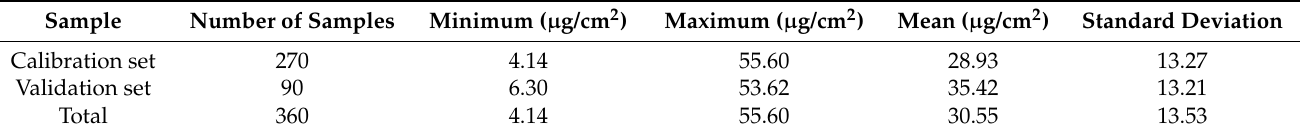
Table 2. Basic characteristics of the